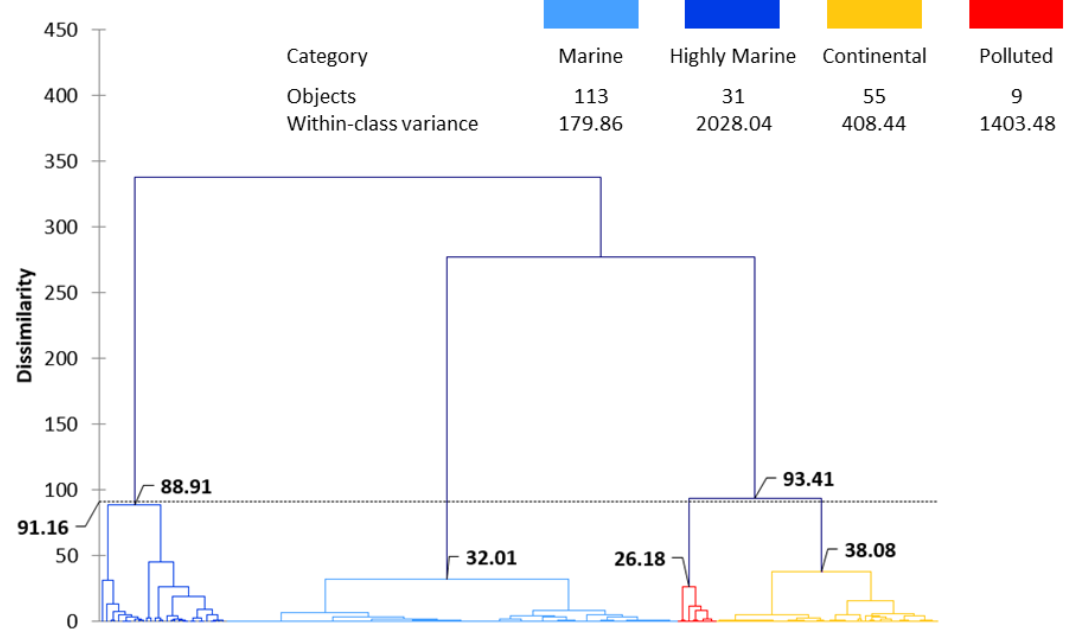
Figure 1. Dendrogram representing the agglomerative hierarchical clustering (AHC) based on dissimilarities using the Ward’s method on 6 inorganic ion concentrations. The 208 cloud samples (without chemical missing values) were assigned to one of four automatically established categories (dissimilarities values displayed in bold). The six ions are the same as those used for principal component analysis (PCA).